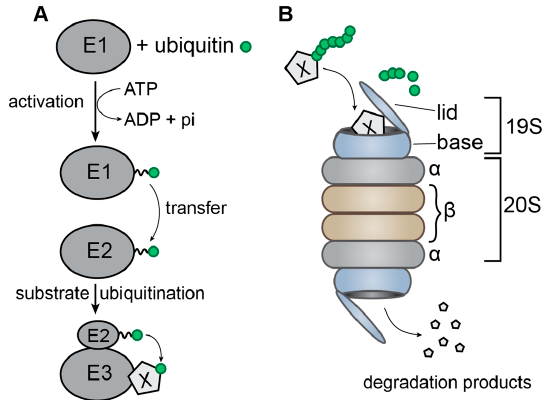
Figure 1. Schematic representation of the ubiquitin-proteasome system. ( A ) Transfer of ubiquitin from the ubiquitin-activating enzyme E1 to the ubiquitin-conjugating enzyme E2 followed by its transfer onto the target protein X by the ubiquitin ligase E3. The broken line symbolizes the thiol-ester bond; ( B ) the 26S proteasome, composed of the 20S barrel and two 19S lids. The ubiquitinated target protein X is recognized by one of the lids and translocated through the barrel where it is degraded by the proteases located on the inside of the β